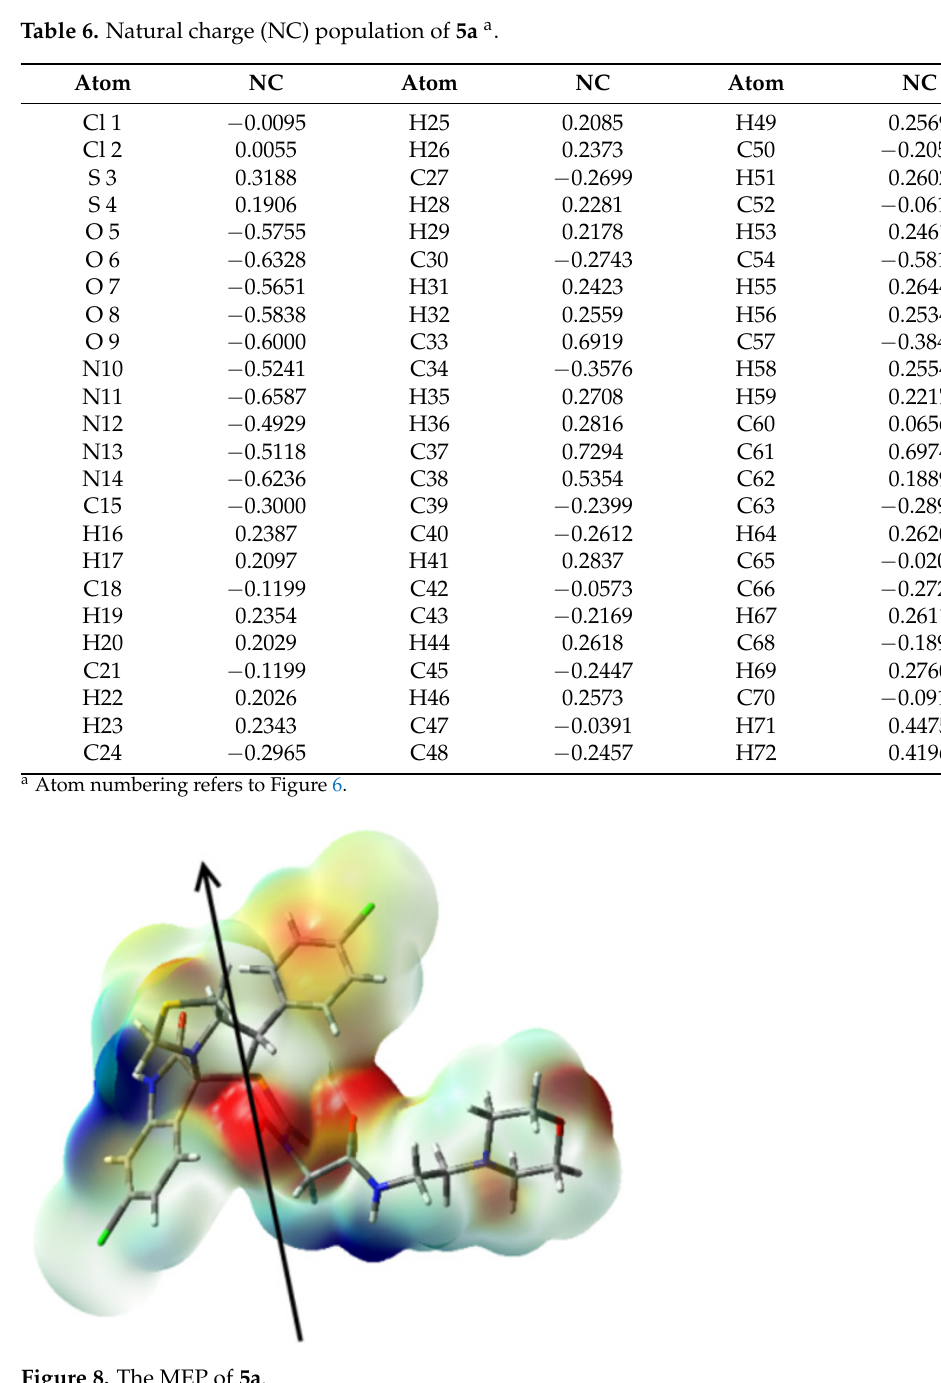
Figure 8. The MEP of 5a .